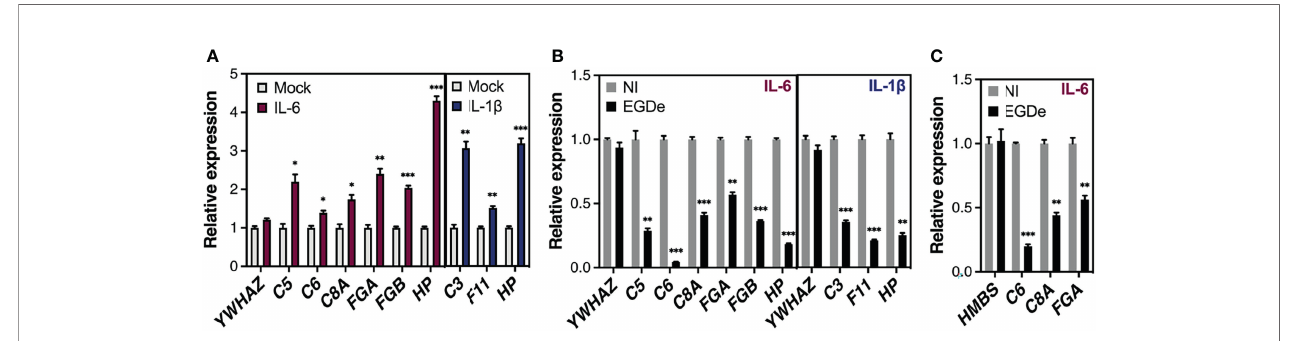
FIGURE 6 | Long-term Listeria infection reduces cytokine-driven expression of APP genes in human hepatocytes. (A) Huh7 cells were stimulated with IL-6 (50 ng/ mL) or IL-1 b (10 ng/mL) for 24 h. Gene expression was analyzed by RT-qPCR and is expressed as fold-induction relative to mock-stimulated cells; IL-6 induced the expression of C5 , C6 , C8A, FGA , FGB and HP genes, while IL-1 b induced C3 , F11 and HP genes. (B, C) Effect of infection on cytokine-induced APP gene expression in Huh7 (B) and HepG2 cells (C). Cells were infected with strain EGDe (MOI~1-5) for 48 h or remained non infected (NI). IL-6 (50 ng/mL) or IL-1 b (10 ng/ mL) (Huh7) or IL-6 (25 ng/mL) (HepG2) was added to infected and NI cells and transcript levels relative to stimulated NI cells were quanti fi ed by RT-qPCR 24 h later (at 72 h p.i., i.e. 24 h post-stimulation). A control gene whose expression was affected neither by infection nor cytokine stimulation is included. (B) In Huh7 cells, the control gene was YWHAZ and gene expression was normalized to PPIA ; (C) In HepG2 cells, the control gene was HMBS and gene expression was normalized to YWHAZ . All values represent mean ± SD (n=3). Statistical signi fi cance, Student ’ s t test (* p < 0.05, ** p < 0.01, *** p <